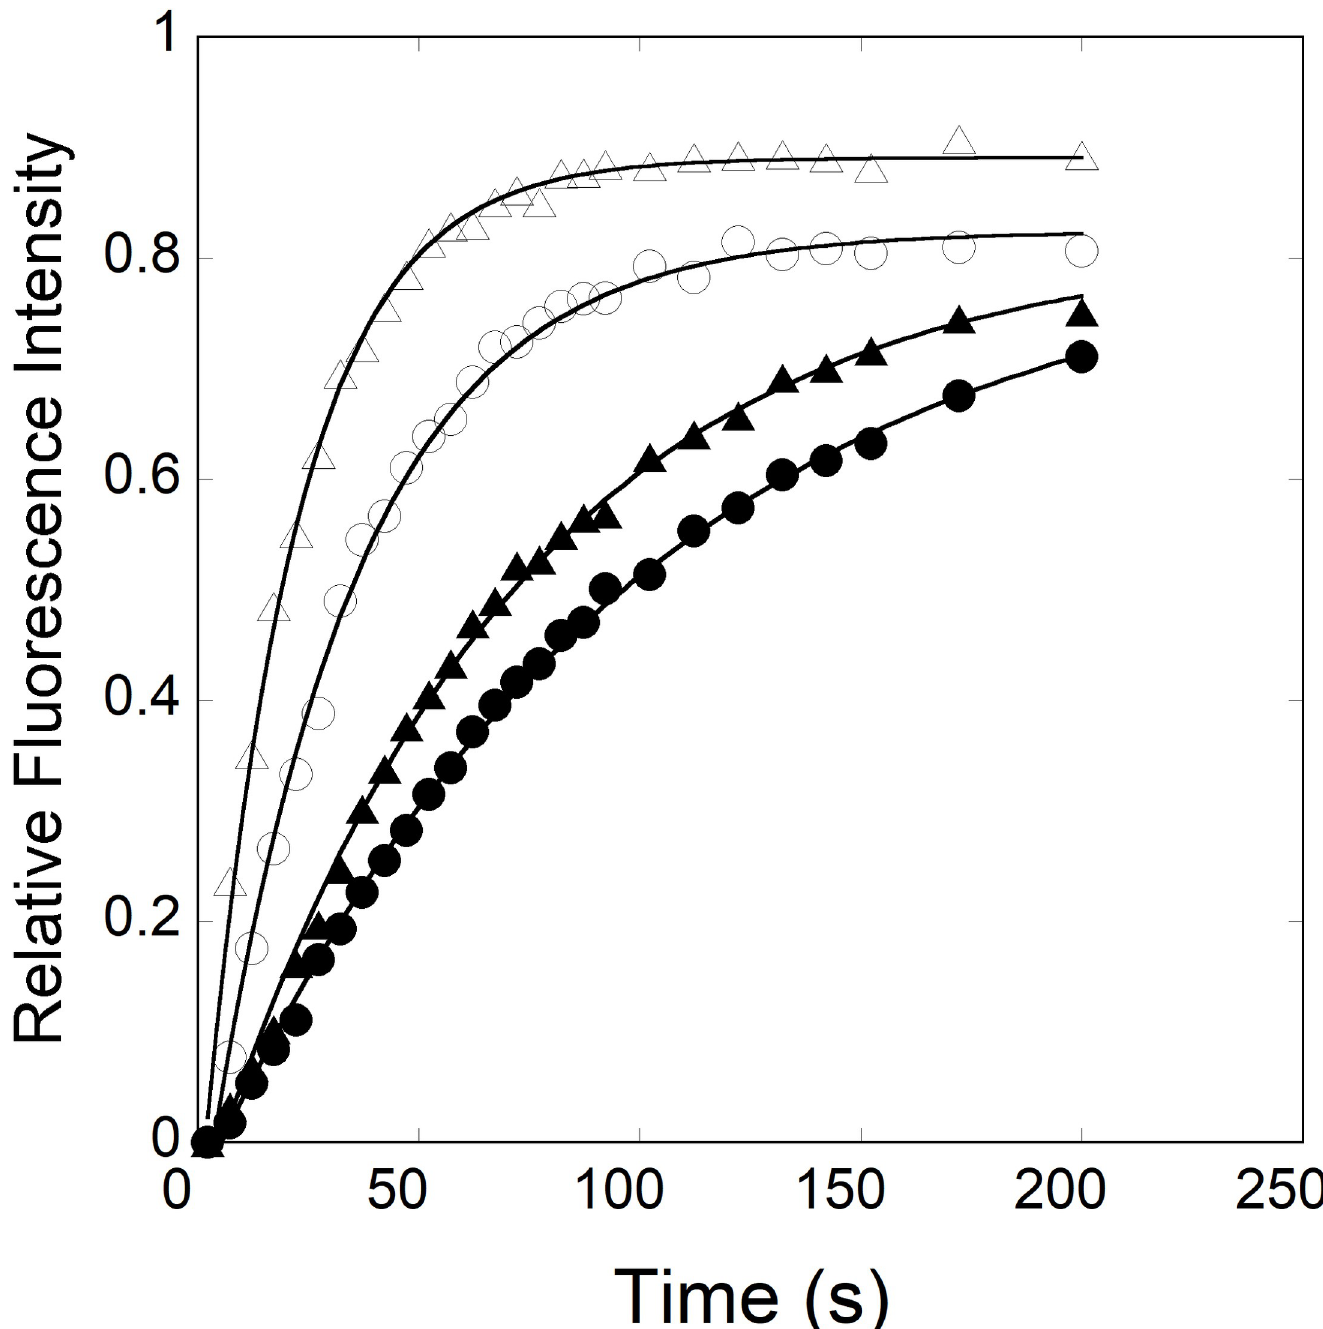
Fig 7. Kinetics of the IRE RNA dissociation from the pre-formed eIF4F � IRE RNA complexes in the absence and presence of iron. Dissociation rate constant ( k -2 ) for eIF4F � FRT IRE RNA (—O—), eIF4F � FRT IRE RNA-Fe 2+ (— ● —), eIF4F � ACO2 IRE RNA (— Δ —), and eIF4F � ACO2 IRE RNA-Fe 2+ (— ▲ —) complexes were monitored by rapidly diluting 100 μ l of the complex with 1500 μ l of buffer at 20 ˚C. Concentrations of IRE RNA, eIF4F and Fe 2+ were 1 μ M, 0.1 μ M and 50 μ M, respectively, after reactants were mixed.